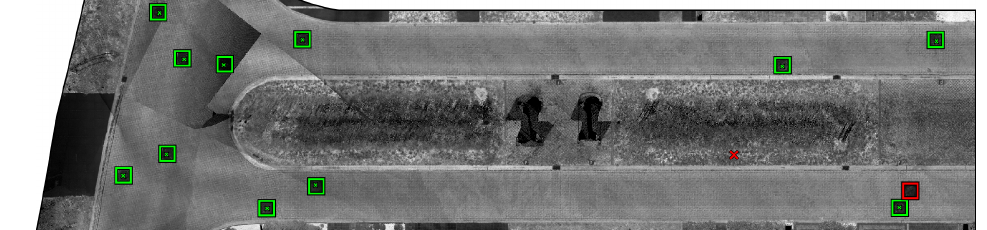
( a ) VGG16 trained on dataset 1 with intensity images with localization parameters T class = 0.8 and T cluster = 10.